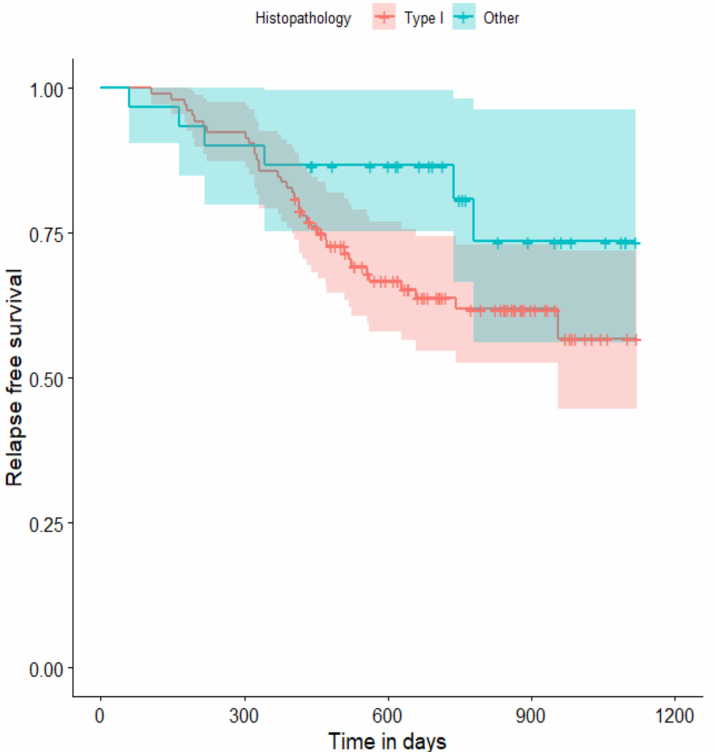
Figure 8. Relapse-free survival curve with 95% CI (darkened area) broken down by histopathology result (serous cancer vs. other types).